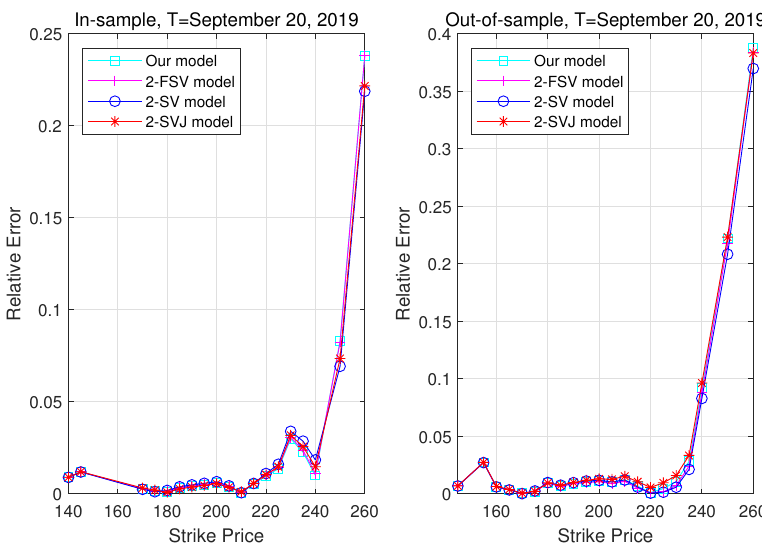
Figure 8. The comparison of predicted prices of four model specifications and market prices on 9 May 2019, with maturity T = 20 September 2019.